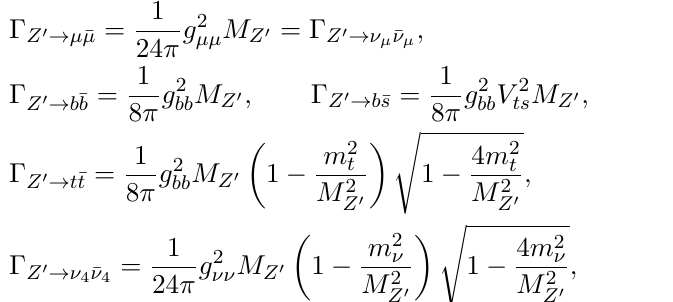
Figure 1 . The parameter space in the ( g (cid:22)(cid:22) ; g bb ) plane compatible with R constraints (white). The Z 0 mass varies over the plane, with a unique Z 0 mass for each point in the plane as determined by eq. (3.3). We show the recent B s mixing constraints (light blue), and the trident bounds (orange); for reference we also display the previous weaker B s mixing bounds (dark blue). The green, red, purple and black lines correspond to M Z 0 = 10 ; 100 ; 1000 ; 10000 GeV